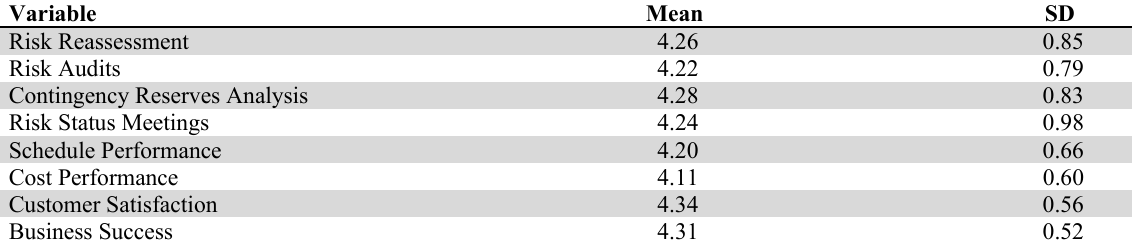
Descriptive statistics of